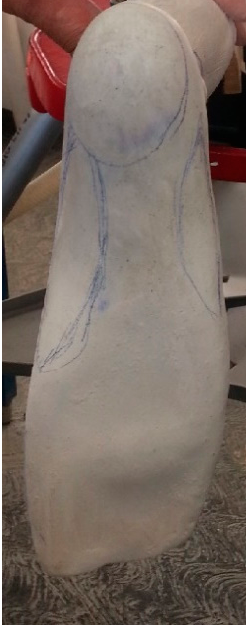
Figure 2. Demonstration of the plantar surface on the plaster model.